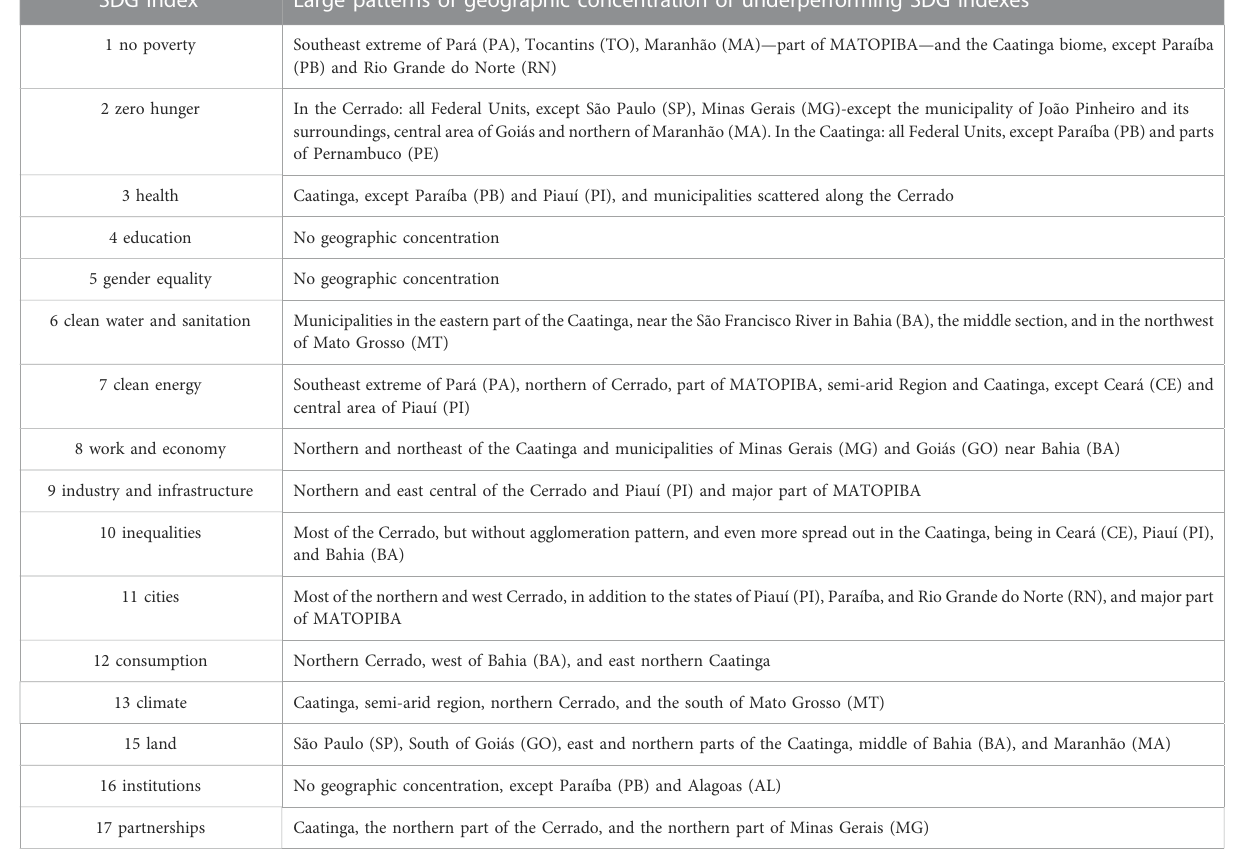
TABLE3presentsthepatternsofgeographicconcentrationofunderperformingSDGindexes.Thesupplementarymaterialcontainsall fi guresasmapsofSDG indexes, Nexus indexes, and sensitivity analysis. SDG index Large patterns of geographic concentration of underperforming SDG